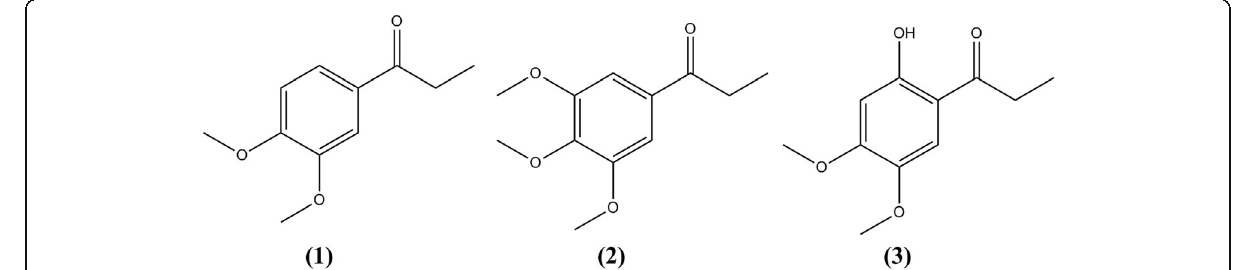
Fig. 1 Chemical structures of propiophenons isolated from ethanolic extract of B. montanum